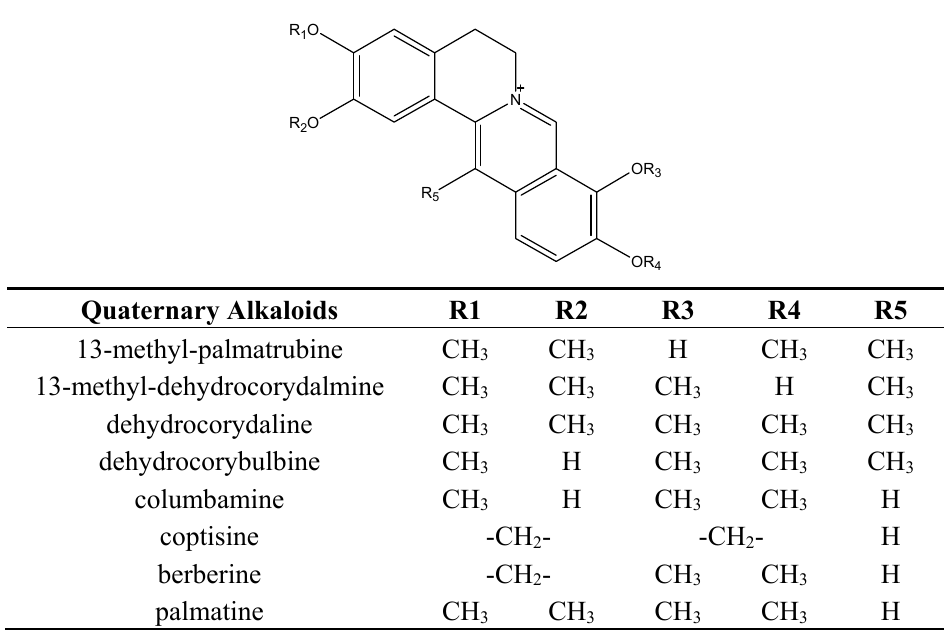
Figure 2. The quaternary alkaloids from